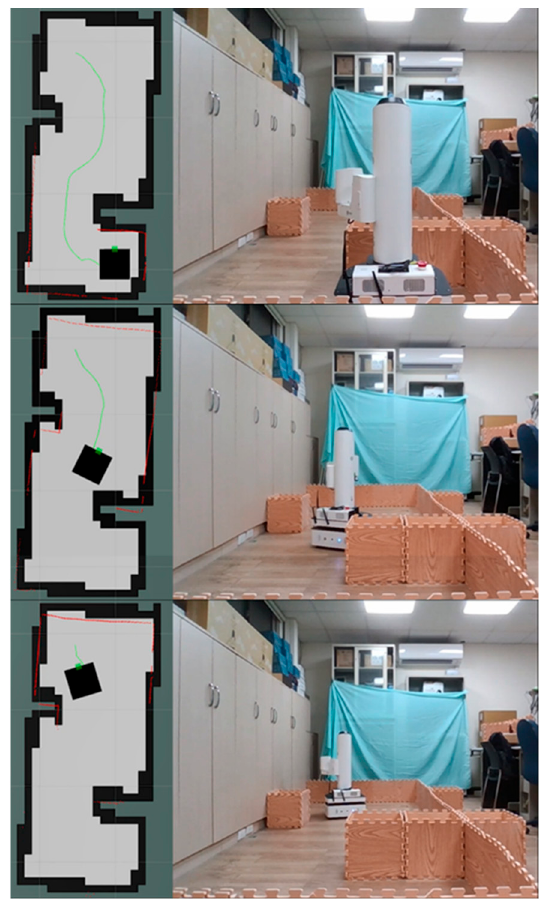
Figure 11. The experimental map without obstacles.